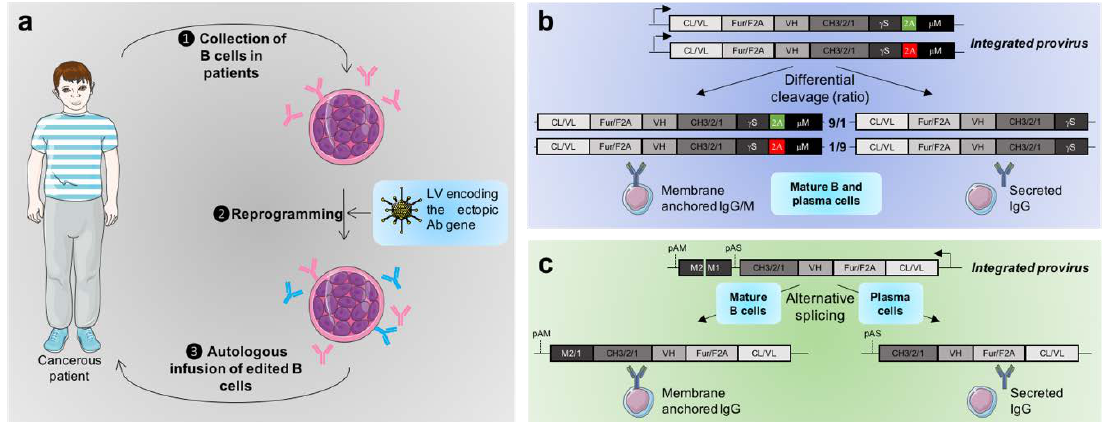
Figure 1. Reprogramming approach for the ectopic expression of membrane anchored and/or secreted antibodies. ( a ) Clinical approach. B cells from patients would be collected, modified, and then re-infused. Ex vivo B cell receptor insertion would be achieved by transduction with a lentiviral vector carrying the antigen-specific immunoglobulin sequence. ( b ) The molecular rheostat approach. A LV construct encoding the membrane-anchored and/or secreted form of an antigen-specific-IgG1/M driven by Ig κ light chain promoter (FEEK) was generated. The constant IgG1 heavy chain (CH) and κ light chain (CL) genes were fused to the variable regions (VL and VH) of a monoclonal antibody directed against a specific antigen. Co-expression of CHs and VHs were obtained by introduction of the F2A peptide sequence. A 2A peptide was included between the secreted γ 1 exon and between the µ M domain. By mutating the 2A peptide, modulation of the secreted IgG and surface chimeric IgG/M BCR ratio can be achieved. ( c ) The FAM2 approach. A LV construct encoding the membrane-anchored and/or secreted form of an antigen-specific-IgG1 driven by Ig κ light chain promoter (FEEK) was generated. The constant IgG1 heavy chain (CH) and κ light chain (CL) genes were fused to the variable regions (VL and VH) of a monoclonal antibody directed against a specific antigen. Co-expression of CHs and VHs were obtained by introduction of the F2A peptide sequence. Two short intronic sequences were included between the CH3 and M1 exons and between the M1 and M2 exons as well as two polyadenylation signals respectively before and after the transmembrane domains. The production of secreted or membrane-anchored immunoglobulins closely mimics the natural expression of these two distinct immunoglobulin forms, which is tightly controlled by alternative splicing and polyadenylation mechanisms during B-cell lymphopoiesis.